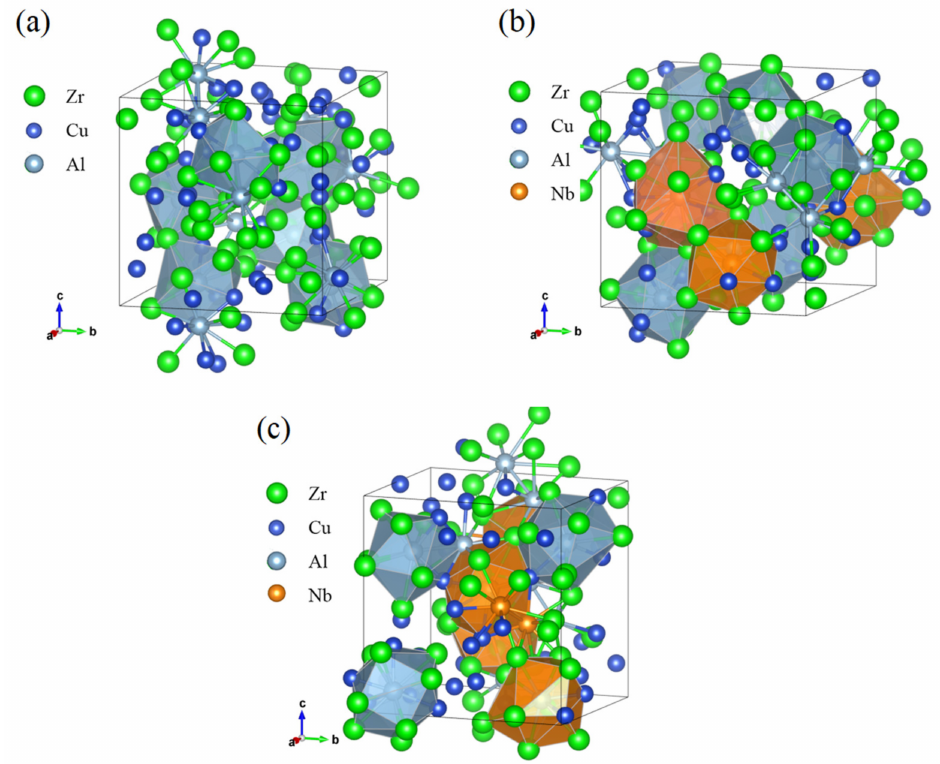
Figure 9. Distribution of stable clusters (closed polyhedra) in cells of simulated amorphous alloys at 300 K: ( a ) Nb0; ( b ) Nb3 and ( c )